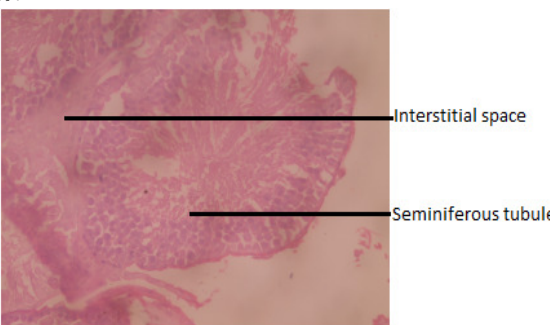
Fig. 5. Photomicrograph of transverse section of typical testicular tissue from group 5 rats (x400 magnification; H&E) Slide shows a normal testicular tissue with essentially normal interstitial cells of